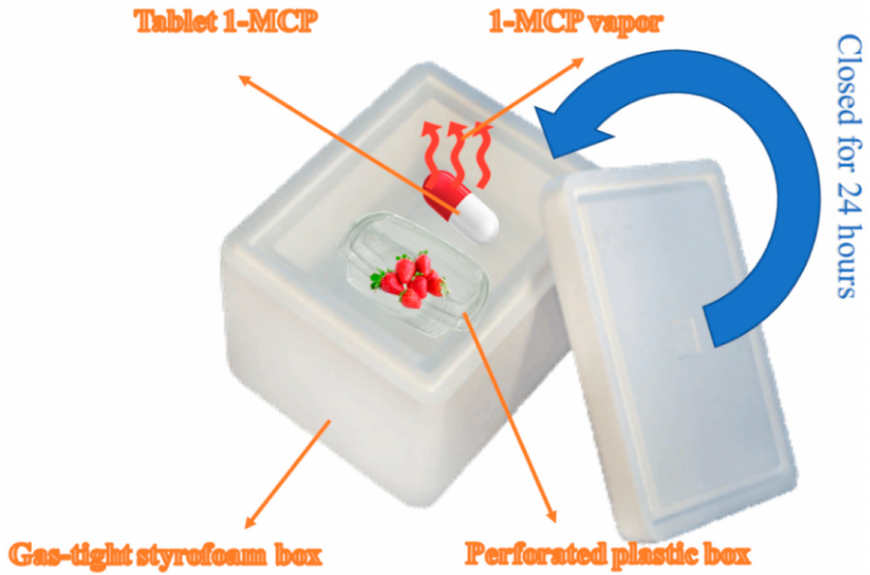
Figure 4. Preparation of 1-MCP and its application to